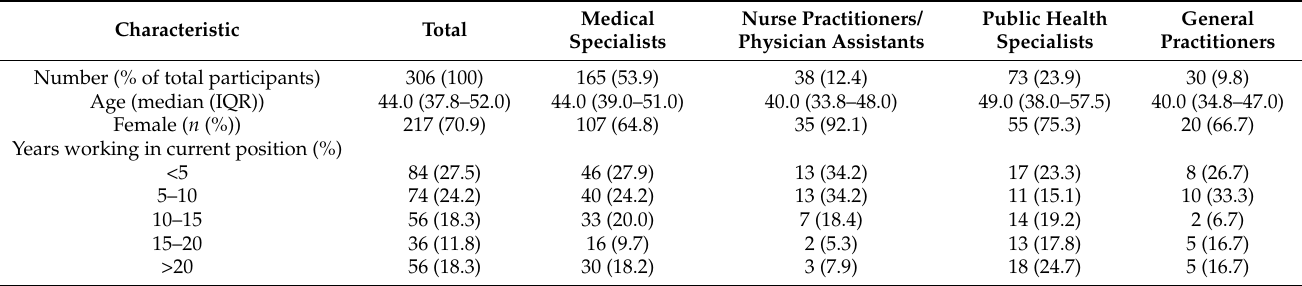
Table 1. Baseline characteristics of